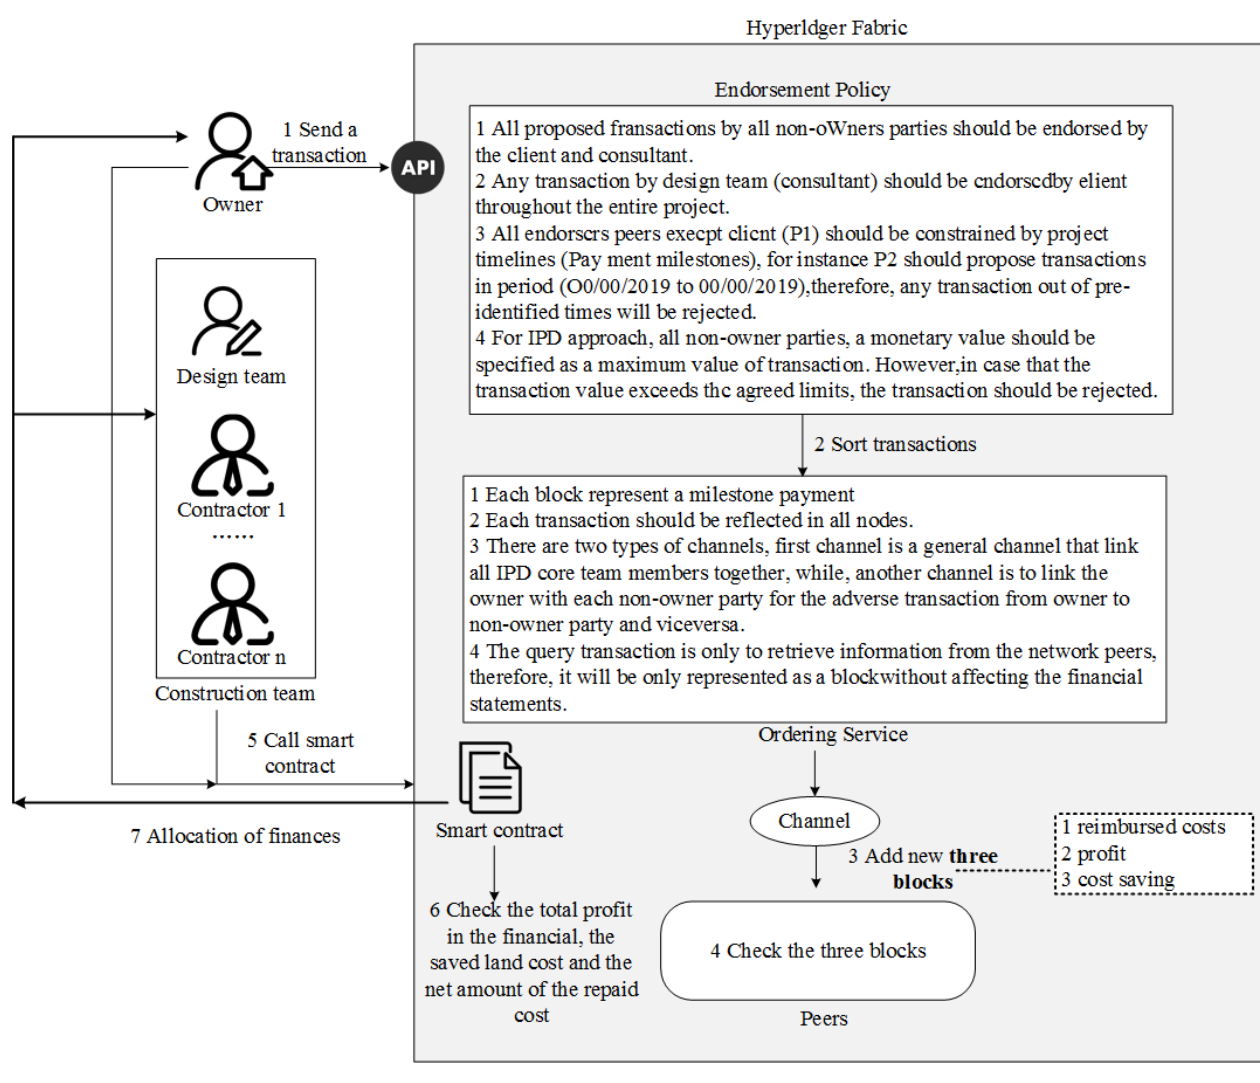
Figure 45. Reconstruction diagram of reference [79].